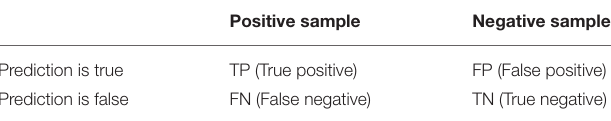
TABLE 1 | Sample table.